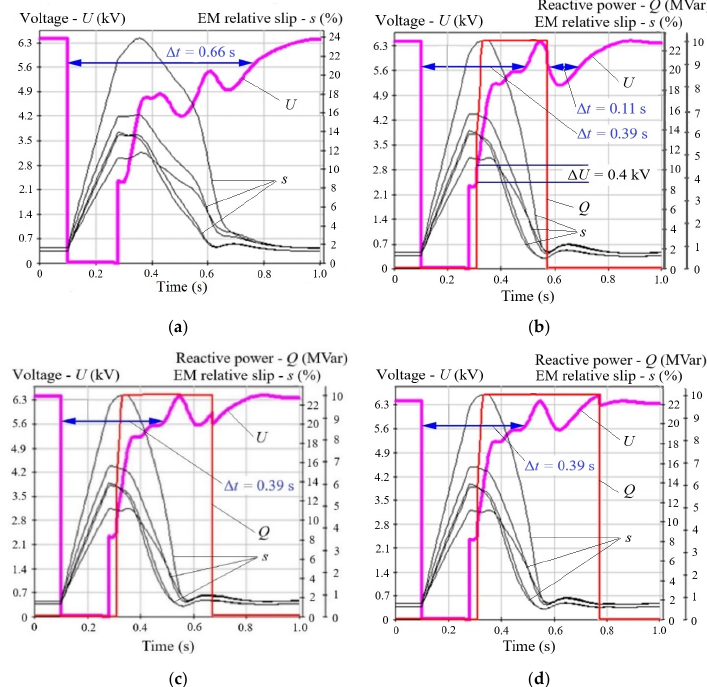
Figure 7. Transients during a three-phase short-circuit: ( a )—without applying the CA to the ESS; ( b )—withdrawal of the CA from the ESS when U GREPnom is reached; ( c )—withdrawal of the CA from the ESS with a time delay of 0.1 s; ( d )—withdrawal of the CA from the ESS with a time delay of 0.2 s.